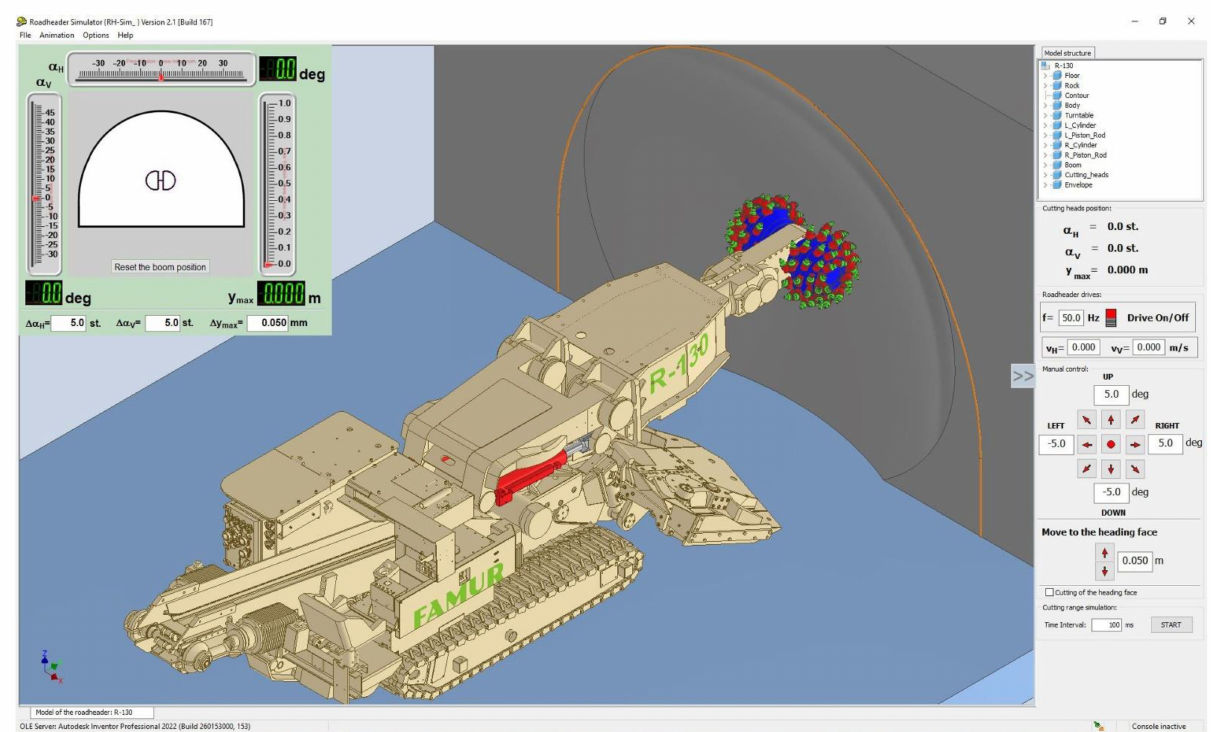
Figure 10. The main screen of the RH-Sim _research